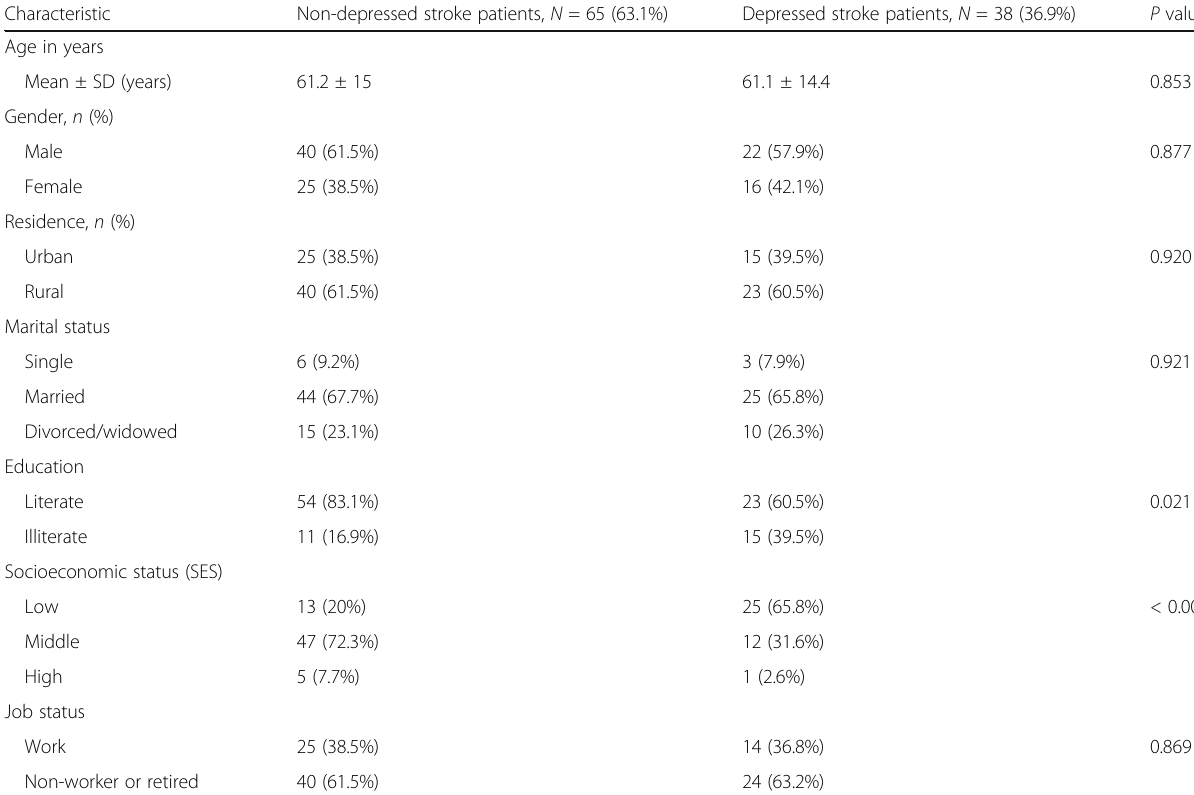
Table 2 Demographic and socioeconomic data for post-stroke depression Characteristic Non-depressed stroke patients, N = 65 (63.1%)